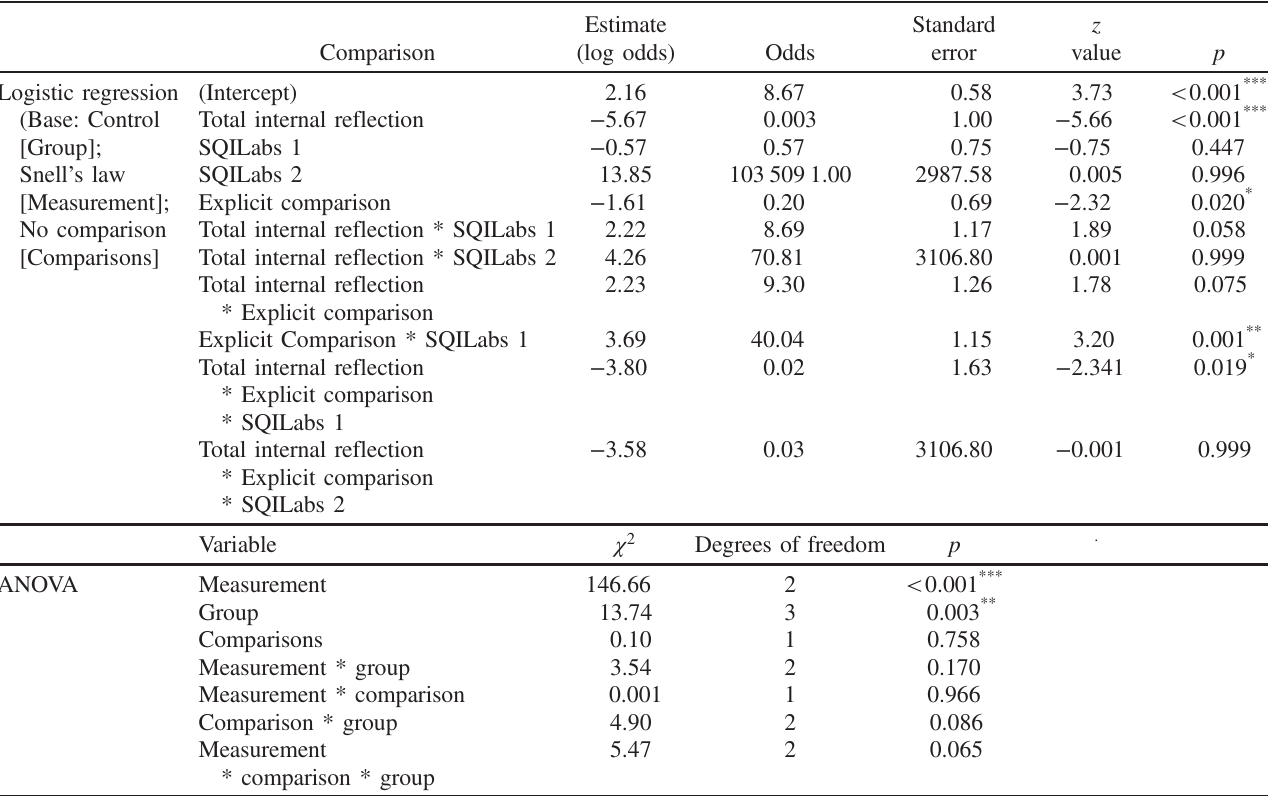
TOOLBOXES AND HANDING STUDENTS TABLE V. Logistic regression table for whether students made changes to their Snell ’ s law and total internal reflection measurements. Base comparison is the control group (for year) and Snell ’ s law (for measurement). This regression failed to reach appropriate convergence and so has limitations on interpretability. * p < 0 . 05 , ** p < 0 . 01 , *** p < 0 . 001 .